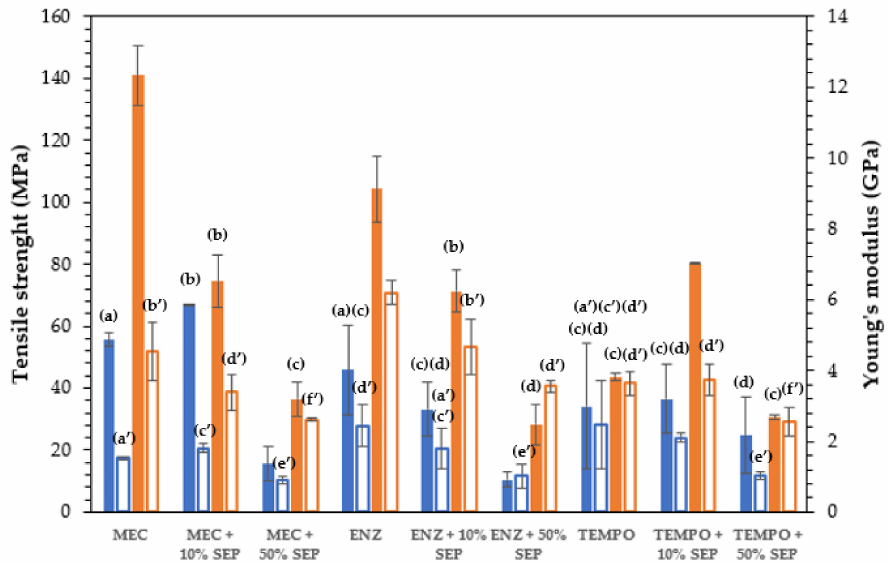
Figure 3. Mechanical properties of the films prepared by solvent casting (blue bars) and by filtration + hot pressing (orange bars). Tensile strength (full bars) and Young’s modulus (empty bars). Same letter above the bars means no statistical difference ( p < 0.05) between preparation methods (tensile strength: (a) to (d); Young’s modulus: (a’) to